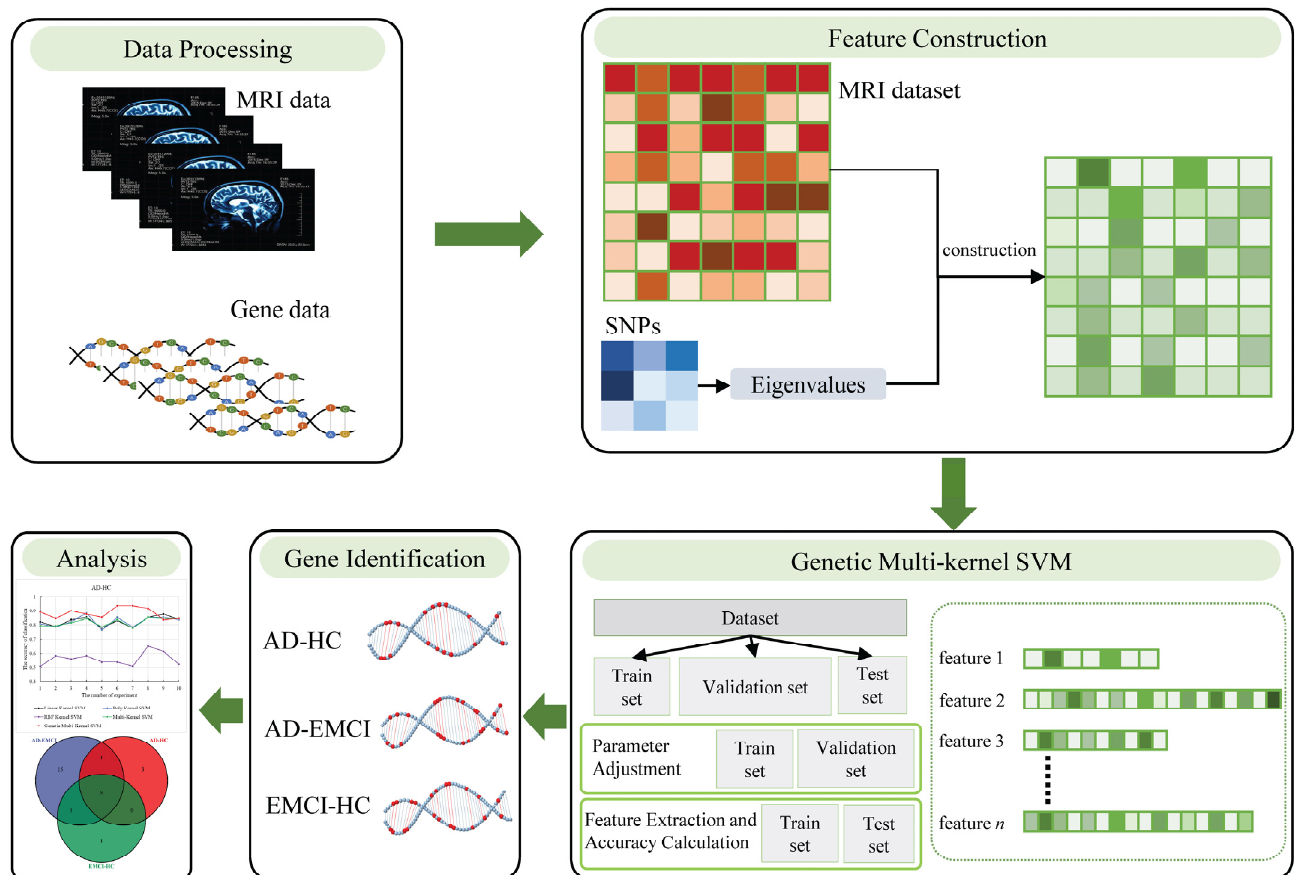
Figure 1. The proposed feature construction method and genetic multi-kernel SVM model.